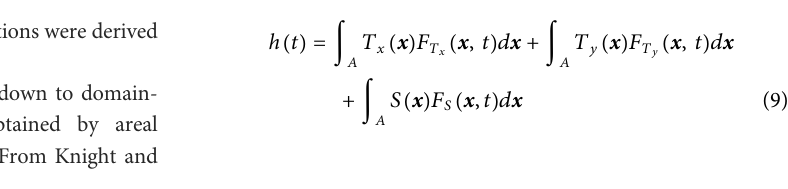
r 1 and r 2 are depicted in Figure 1. Similar equations were derived by Zha et al. (2020).